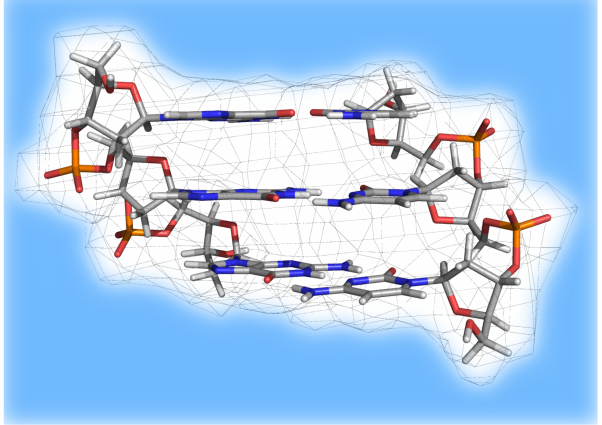
Figure 10. Double-stranded oligonucleotide ds-(5 (cid:48) -GGG-3 (cid:48) ) studied by Kumar et al. [154]. DFT calculations were performed on the atoms represented in stick, whereas the environment (indicated by the the light blue region) was modeled by means of the IEF-PCM implicit solvent